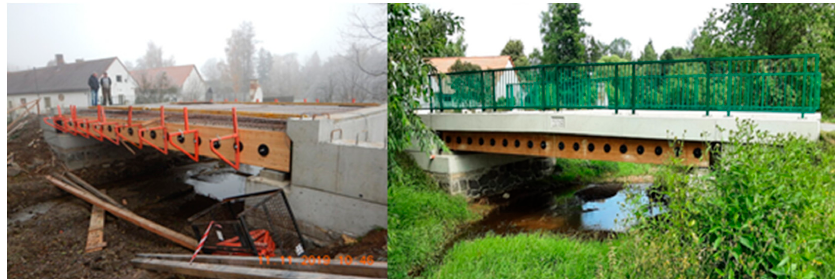
Figure 1. Digital picture of WCB bridge.